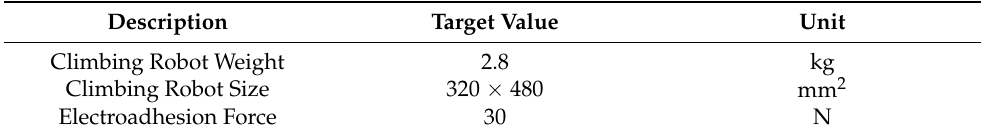
Table 4. System parameters for the prototype climbing robots.